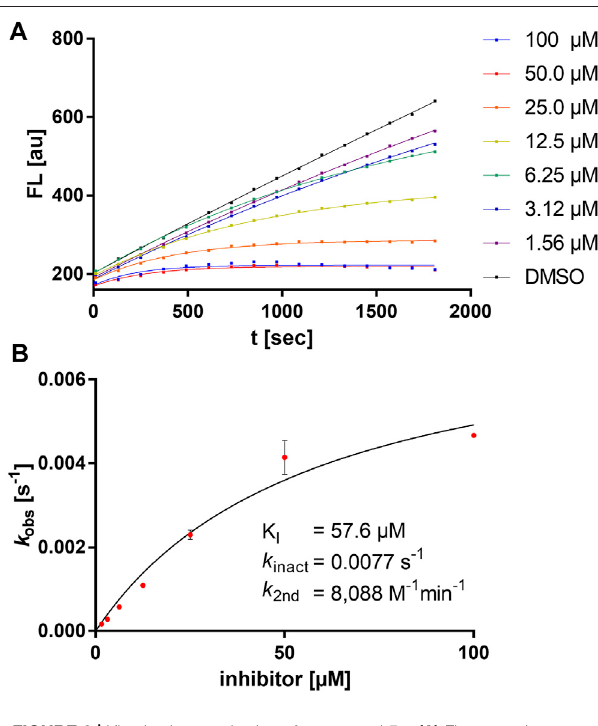
FIGURE 3 | Kinetic characterization of compound 5a . (A) Fluorometric assay with compound 5a showing time-dependent enzyme inhibition with hyperbolic substrate conversion plots. The fl uorescence was recorded for 30 min every 30 s. For clarity, only every fourth data point is shown. (B) k obs vs. (I) for the determination of inhibition constants (K I , k inact ).